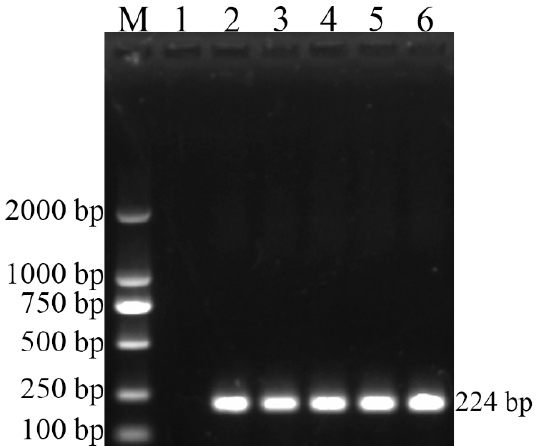
Figure 1. BCSP31-PCR results of the four reference strains and the isolate in this study (CD3). Lane M, molecular weight marker; Lane 1, negative control with no DNA added; Lane 2, DNA extracted from B. abortus (544A); Lane 3, DNA extracted from B. melitensis (16M); Lane 4, DNA extracted from B. suis (S2); Lane 5, DNA extracted from B. canis (RM6/66); Lane 6, DNA extracted from the isolated strain (CD3).